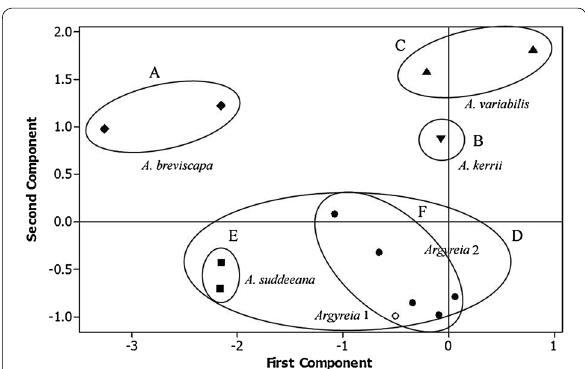
Fig. 7 The scattered plot of first and second components obtained from principal component analysis (PCA) based on 24 anatomical traits. Group A , B , C , D and subgroups E and F corresponding to the phenogram in Fig.